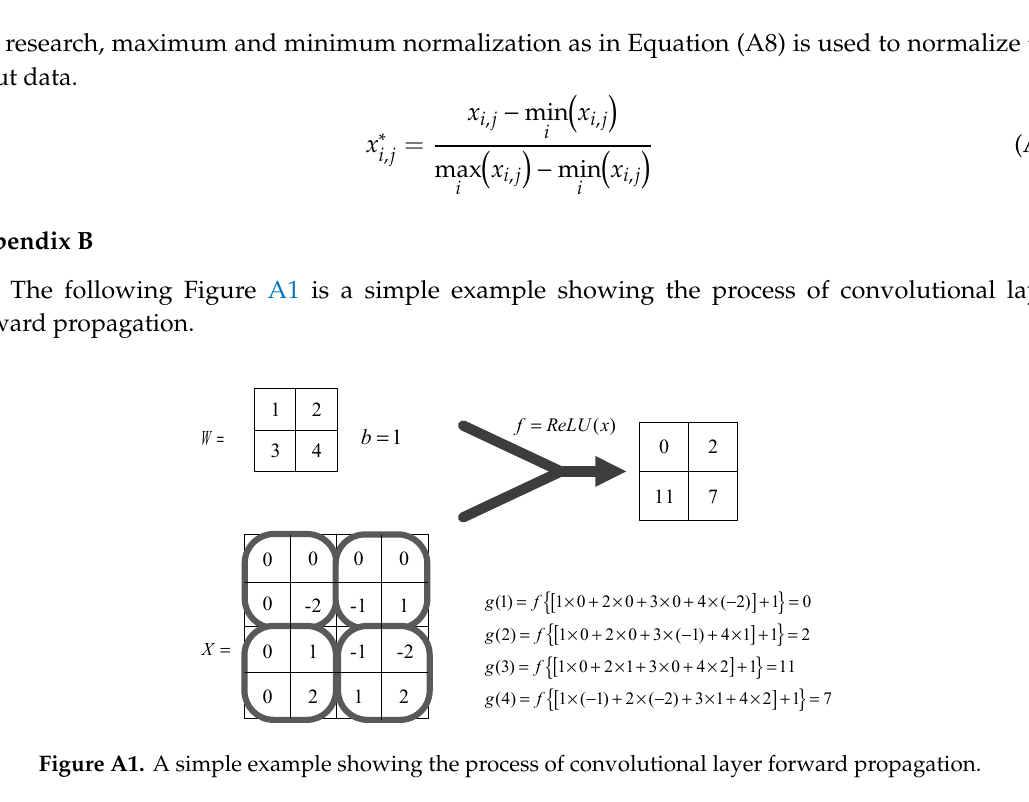
Figure A1. A simple example showing the process of convolutional layer forward propagation.